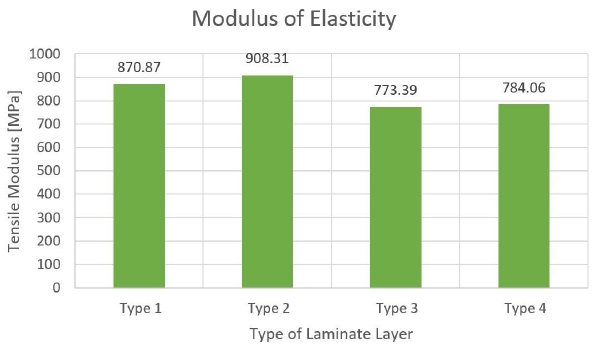
Figure 7: Mass fraction of HCGFRP in each lamina configuration